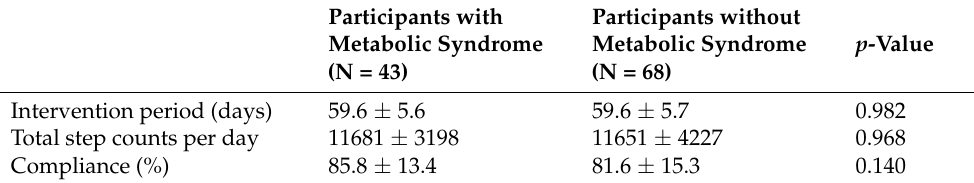
Table 1. Intervention period, total step counts, and compliance of participants.